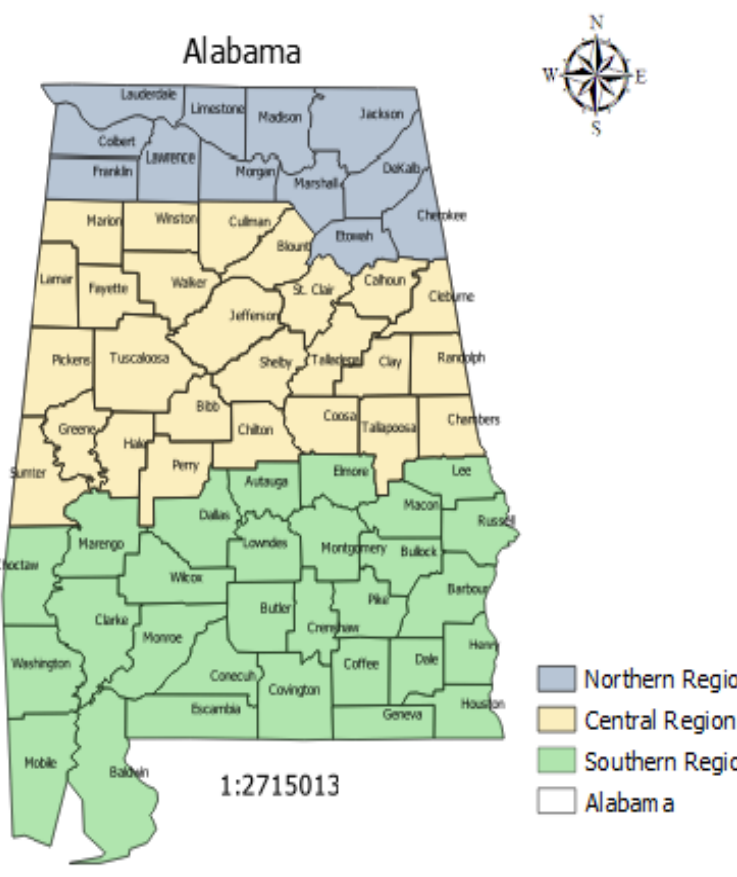
Figure 1. Map of Alabama demonstrating the three primary different regions.